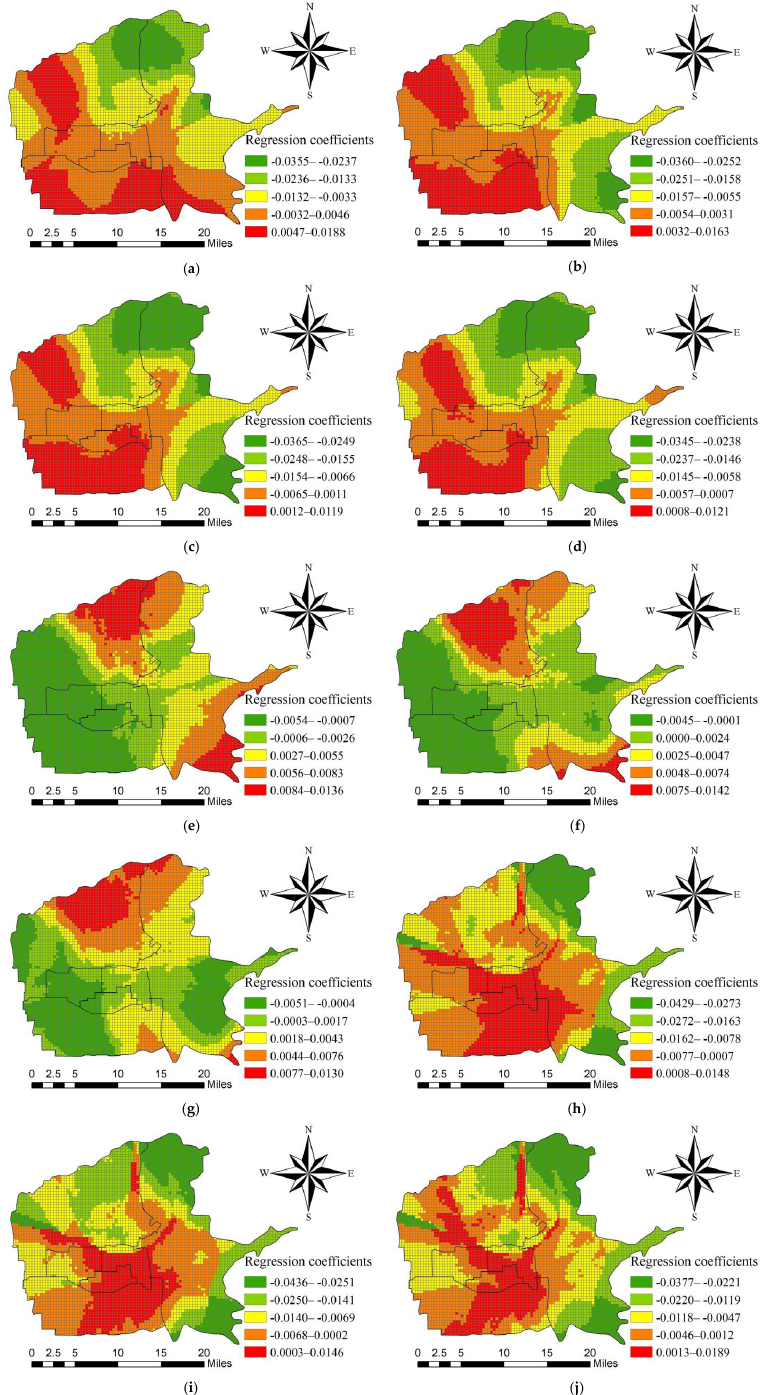
Figure 7. Spatial patterns of road network topological variables regression coefficients. ( a ) NQPDA5000, working days; ( b ) NQPDA10000, working days; ( c ) NQPDA15000, working days; ( d ) NQPDA20000, working days; ( e ) TPBtA10000, working days; ( f ) TPBtA15000, working days; ( g ) TPBtA20000, working days; ( h ) NQPDA10000, non-working days; ( i ) NQPDA15000, non-working days; ( j ) NQPDA20000, non-working days.